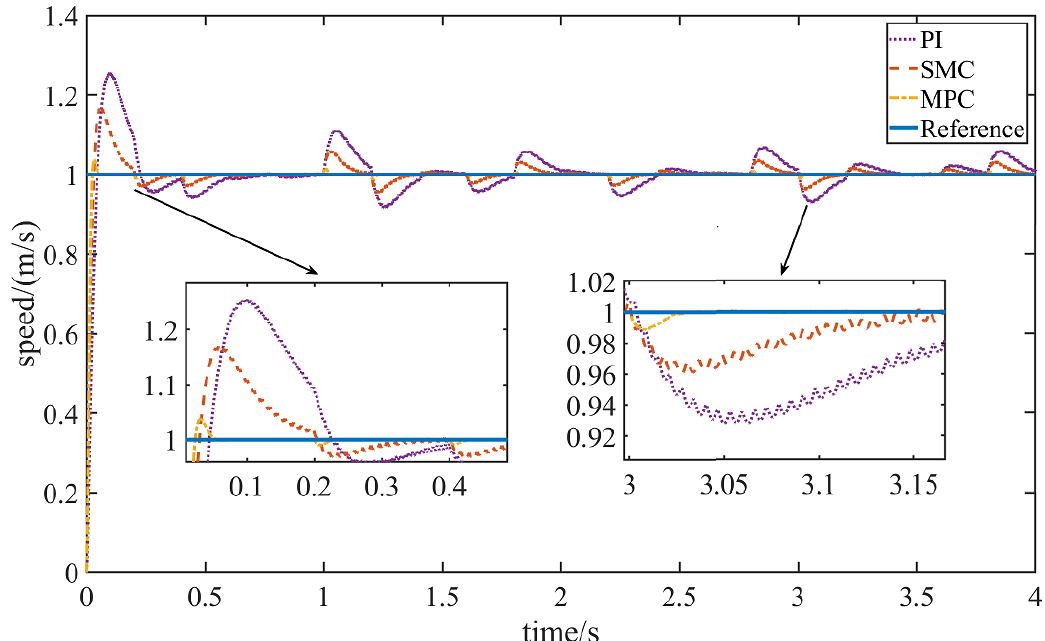
Figure 11. Comparison of operating speeds under random loads.